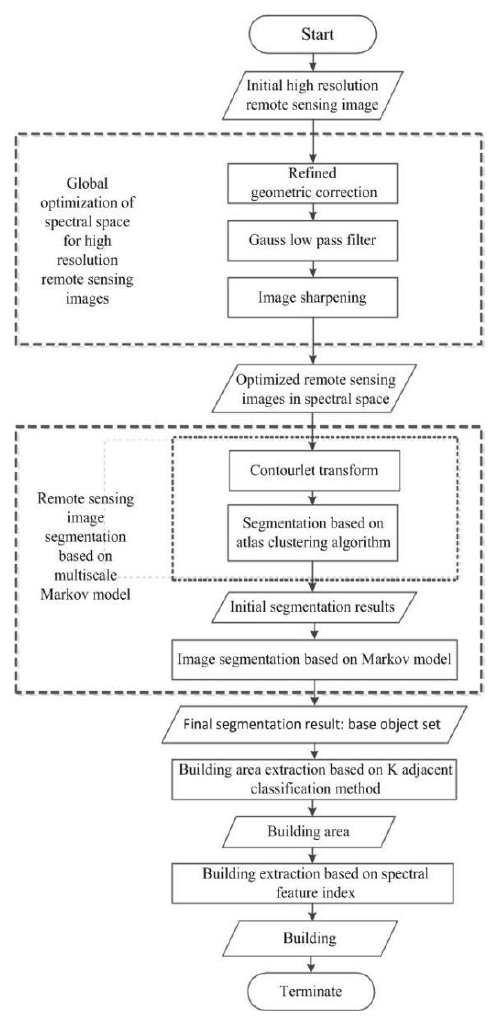
Figure 1. The process of building extraction in this